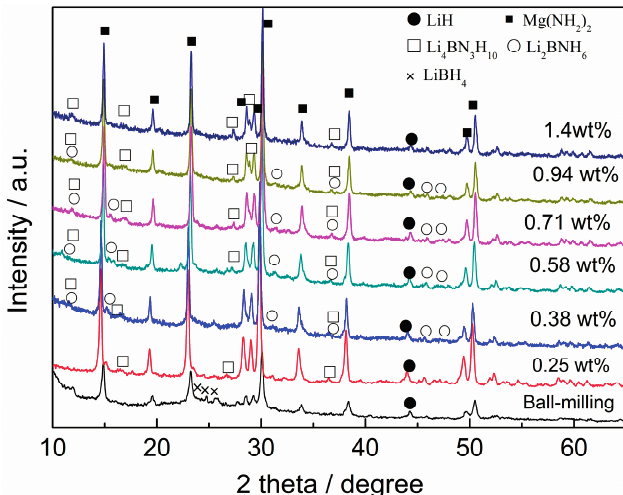
Figure 6. XRD patterns of T 2 (2Mg(NH 2 ) 2 –3LiH–LiBH 4 ) samples collected at 460 K at different degree of dehydrogenation: 0 wt%, ball-milling stage; 0.25 wt%; 0.38 wt%; 0.58 wt%; 0.71 wt%; 0.94 wt%; and 1.4